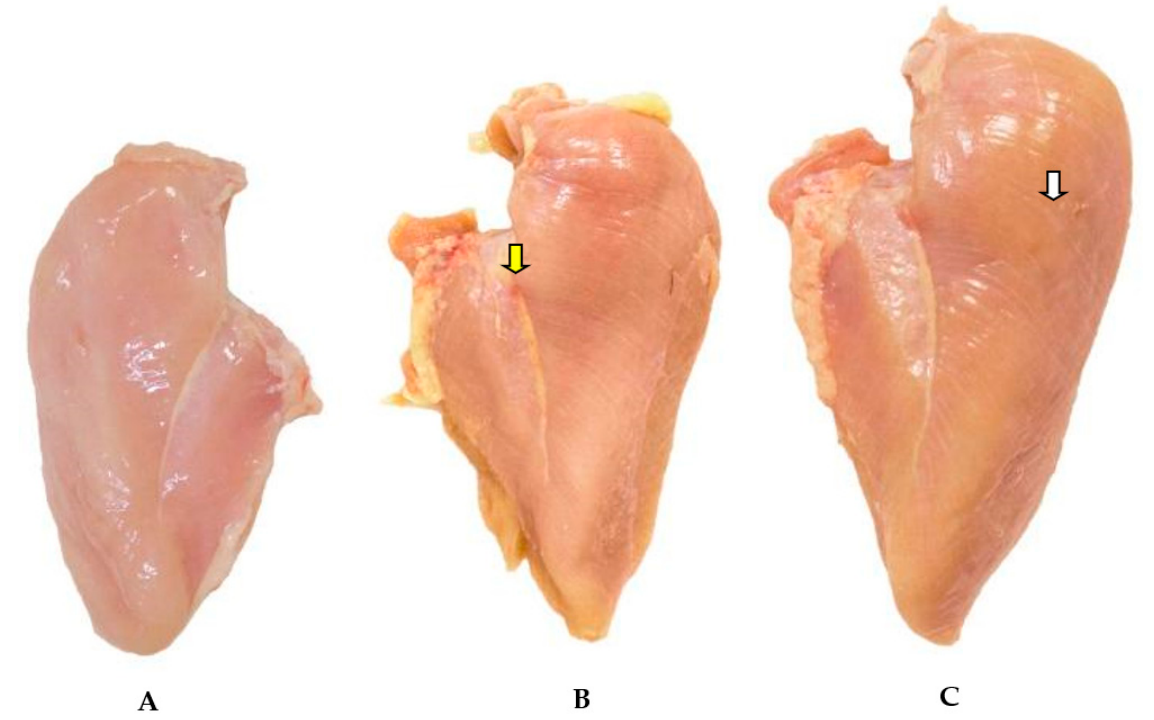
Figure 1. Normal Pectoralis major muscle ( A ), and Pectoralis major muscle affected by the moderate ( B ) and severe ( C ) degree of wooden breast myopathy (WBM) in Cobb broiler chicken. There are reddish (petechiae) and hardened areas in the middle and lower portions of the muscle (yellow arrow), as well as whitish striations in the upper quadrant of the muscle part (white arrow).